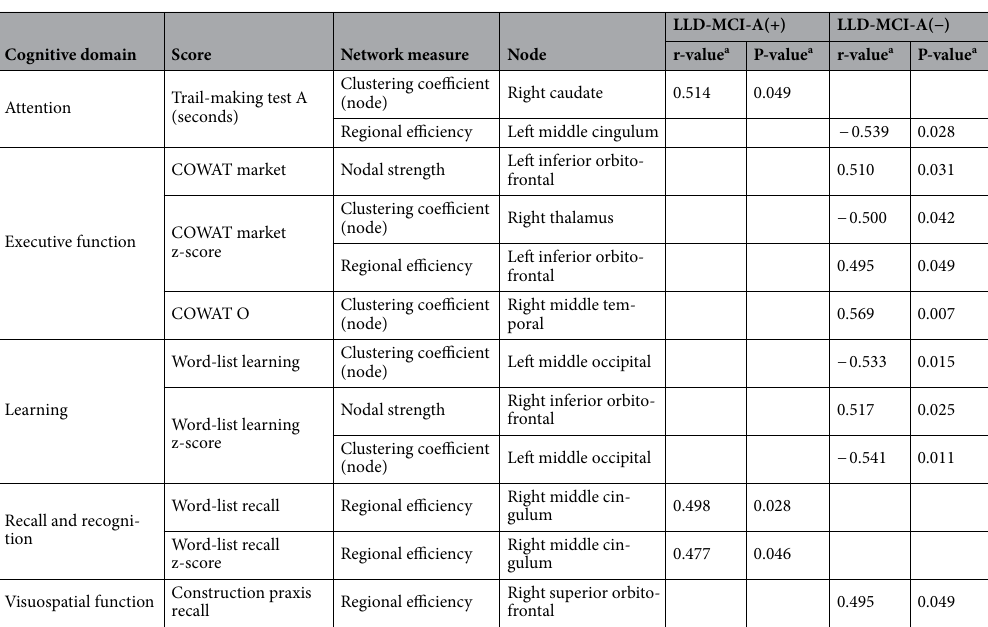
Table 3. Correlation between the nodal network measures and cognitive scores (FDR-survived results only). a Partial correlation coefficient, controlling for age, gender, and education level; the collected P-values were FDR-adjusted across 90